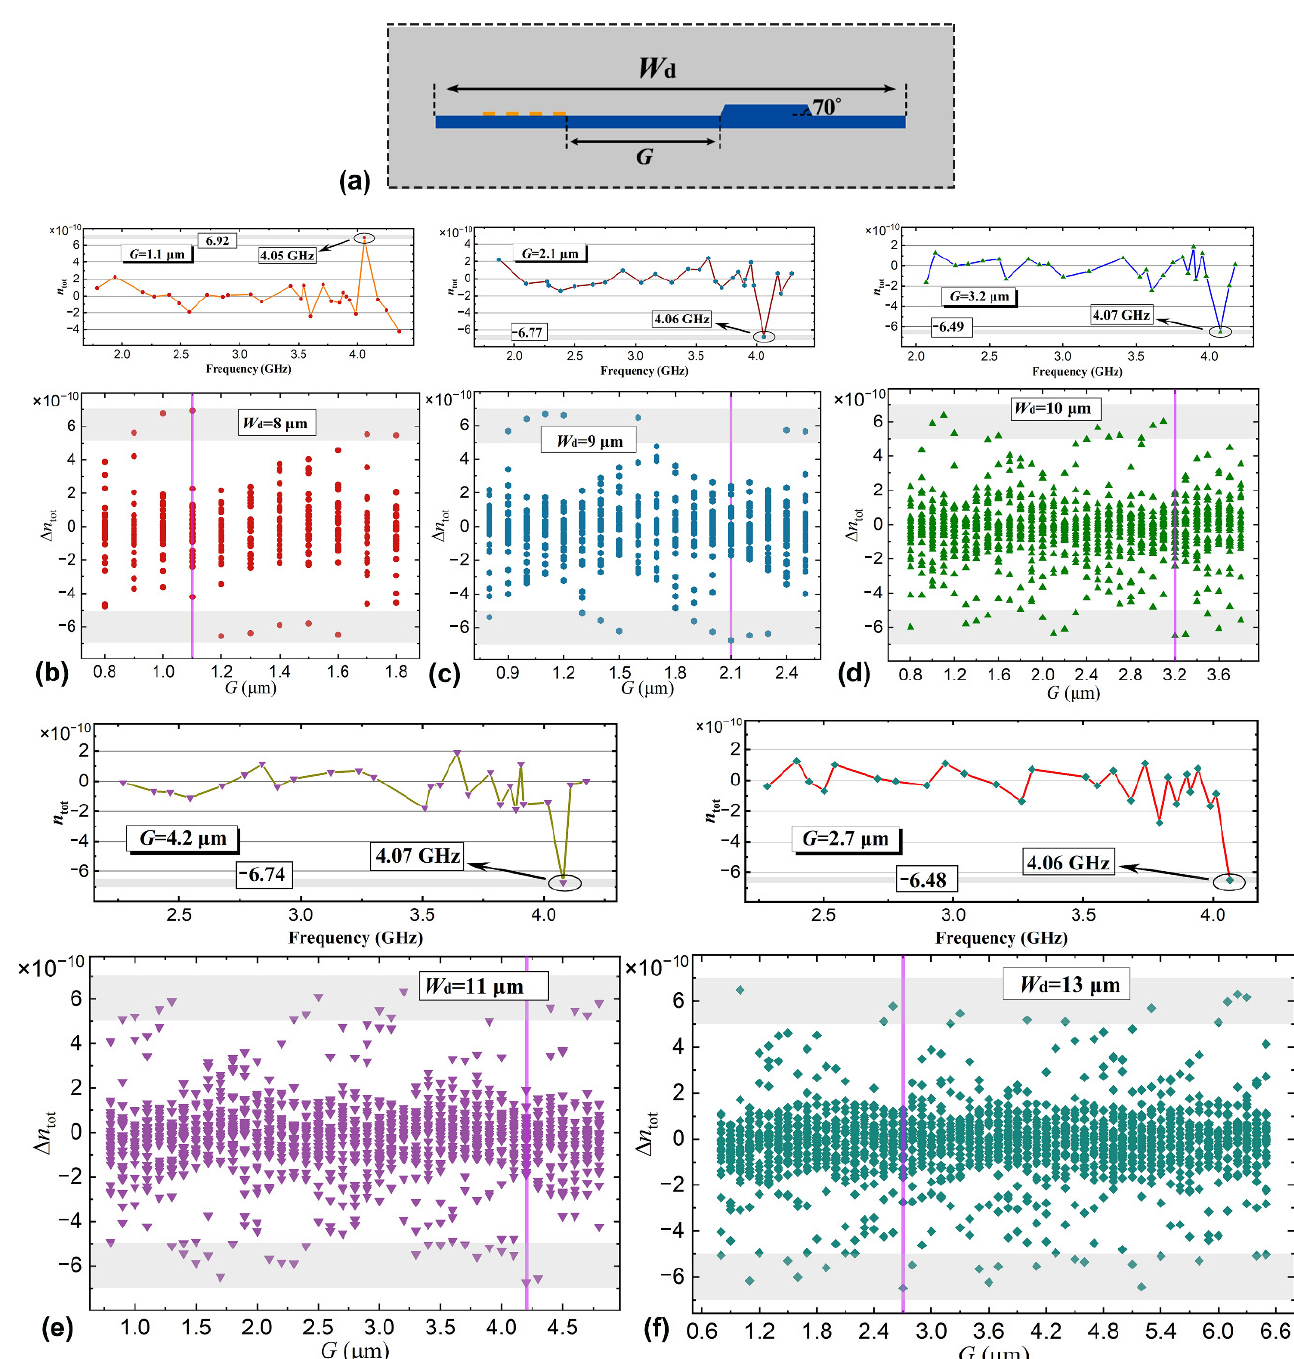
Figure 5. ( a ) A 2D cross section of the acoustic resonator. Its width is W d . The calculated refractive index change of the optical waveguide ∆ n tot versus the gap width G between the optical waveguide and IDT. The acoustic resonator widths are W d = ( b ) 8, ( c ) 9, ( d ) 10, ( e ) 11, and ( f ) 13 µ m, respectively. Vertical lines show the chosen optimum gap widths. The frequency distributions are illustrated in the upper diagram.